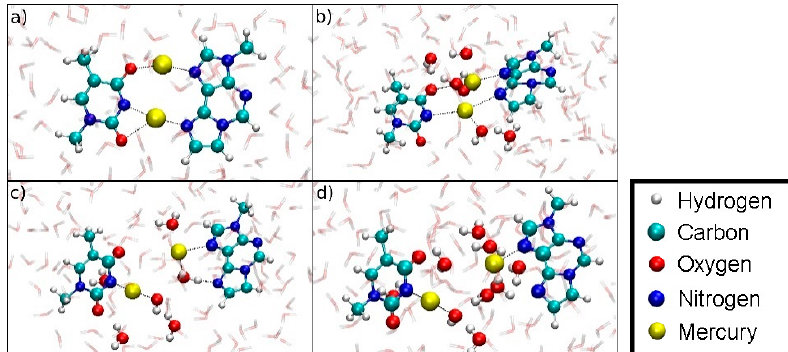
Figure 19. ( a ) Initial geometry at D ISO = 3.6 Å of the dissociation MD for the Hg(II)-free hydrogen- bonded base pair (structure 4 ). ( b ) Dissociation is favoured due to the involvement of a water molecule in hydrogen bonding, which is not possible within a DNA duplex.